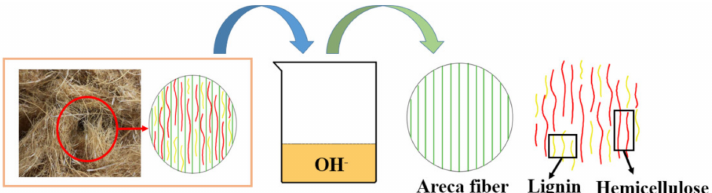
Figure 2. Preparation mechanism of fiber by alkali